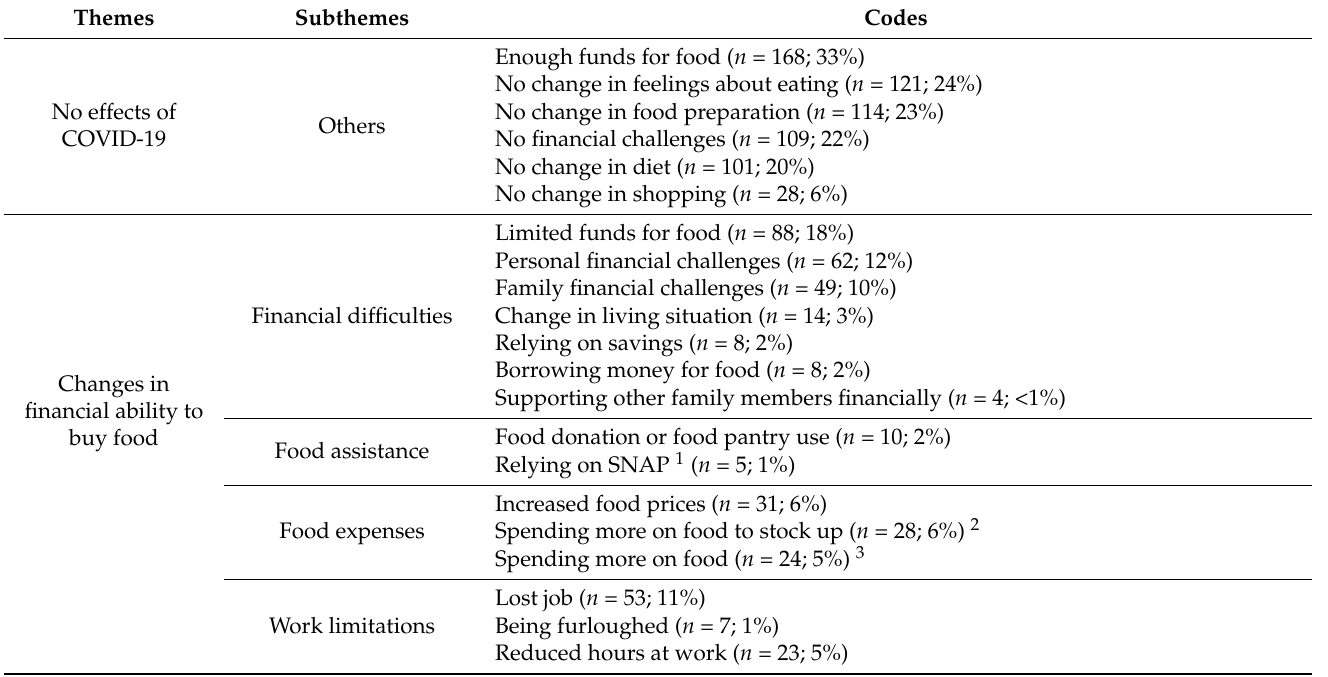
Table 2. Qualitative Codes, Subthemes, and Themes of College Students’ Food and Shopping Habits during the Early COVID-19 Pandemic, Including Number and Percentage of Participants Reporting Codes.